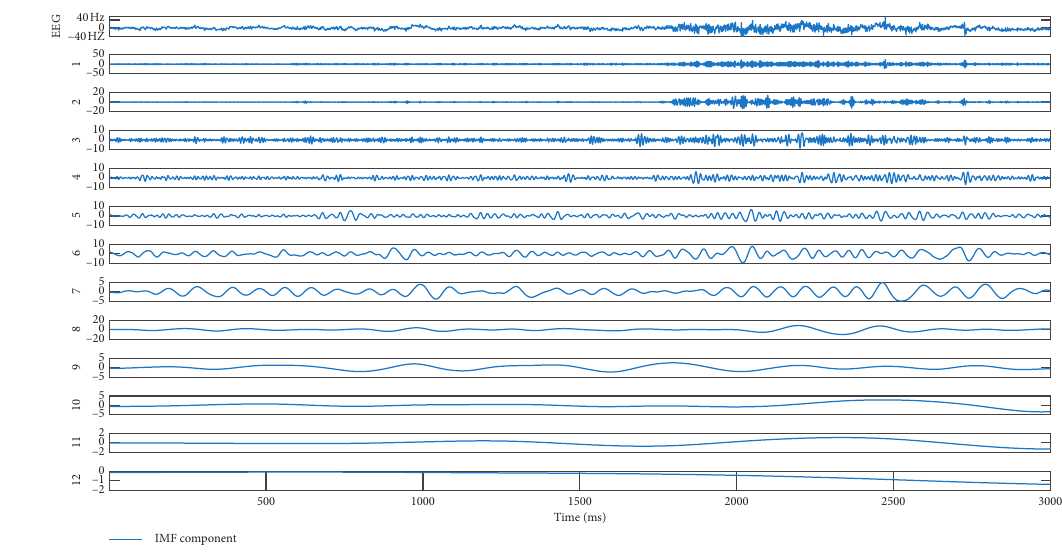
Figure 2: The amplitude and corresponding frequency domain.